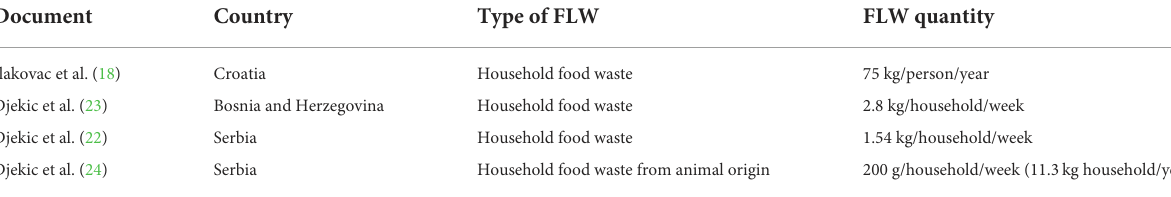
TABLE 3 Quantification of FLW in the Western Balkan